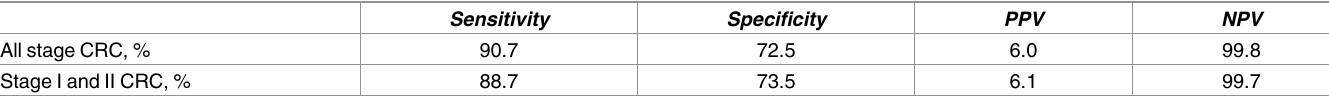
Table 3. Model 12s sensitivity, specificity, PPV, and NPV for